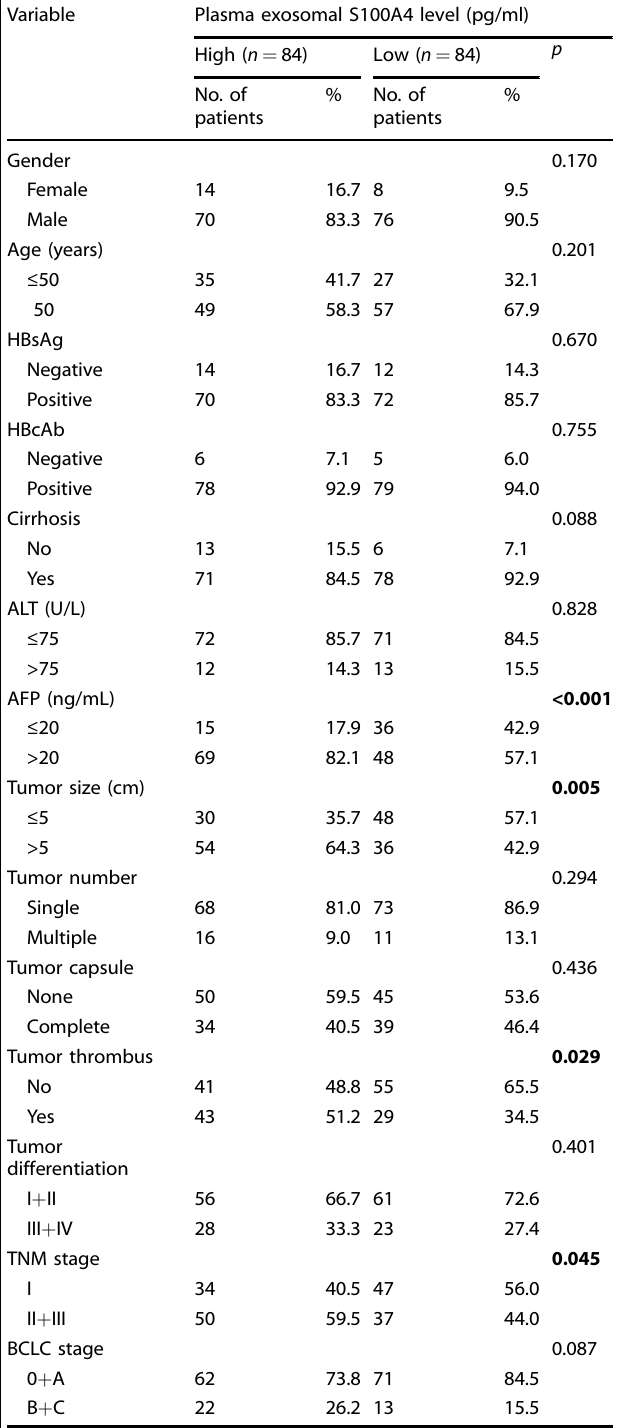
Table 1. Relationship between plasma exosomal S100A4 level and clinicopathologic